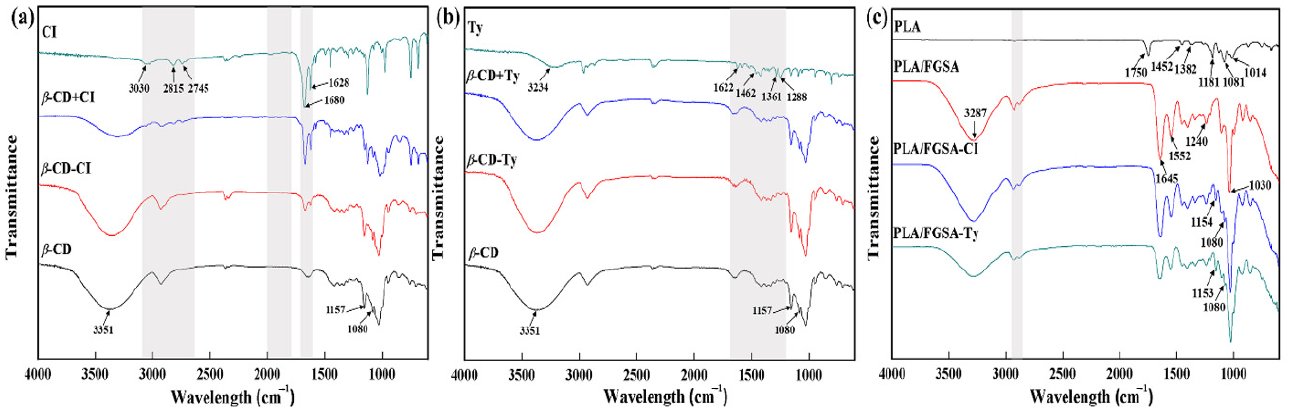
Figure 1. Panel ( a ) : FTIR spectra of CI, β -CD, their physical mixture ( β -CD+CI), and inclusion complexes ( β -CD-CI); panel ( b ): FTIR spectra of Ty, β -CD, their physical mixture ( β -CD+Ty), and inclusion complexes ( β -CD-Ty); panel ( c ): FTIR spectra of PLA and FGSA-based layers of bilayer films (PLA/FGSA, PLA/FGSA-CI, and PLA/FGSA-Ty).